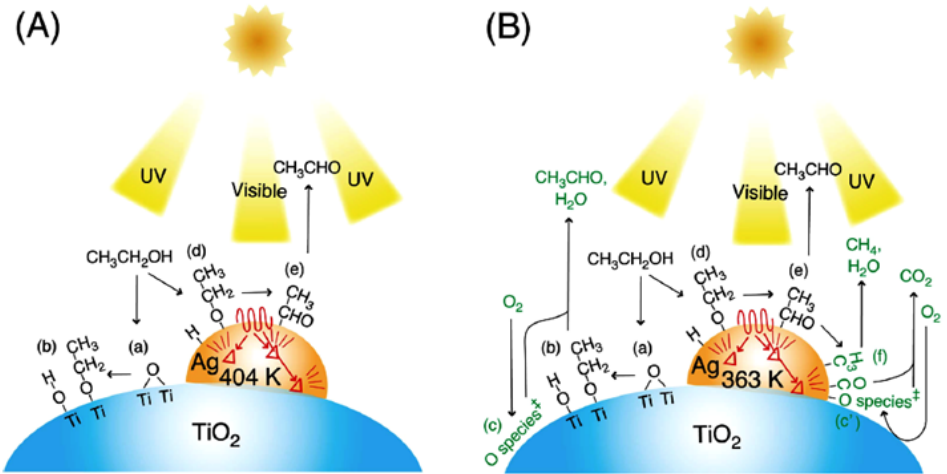
Figure 2. Photocatalytic reaction steps involving: ( A ) Ag-TiO 2 , ethanol, UV-Vis light irradiation and ( B ) Ag-TiO 2 , ethanol, O 2 , UV-Vis light irradiation. Reproduced with permission from ref. [25]. Copyright 2023 American Chemical Society.